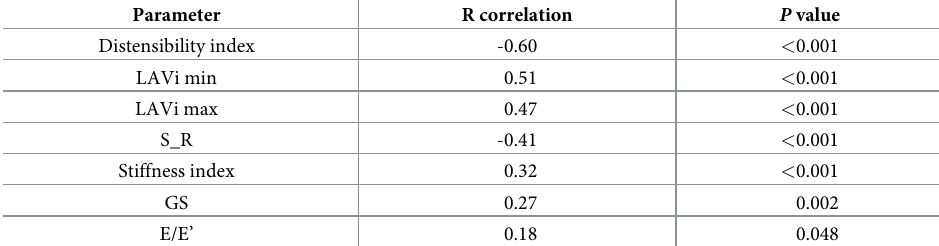
Table 5. Correlations between LA pump function and other echo parameters.